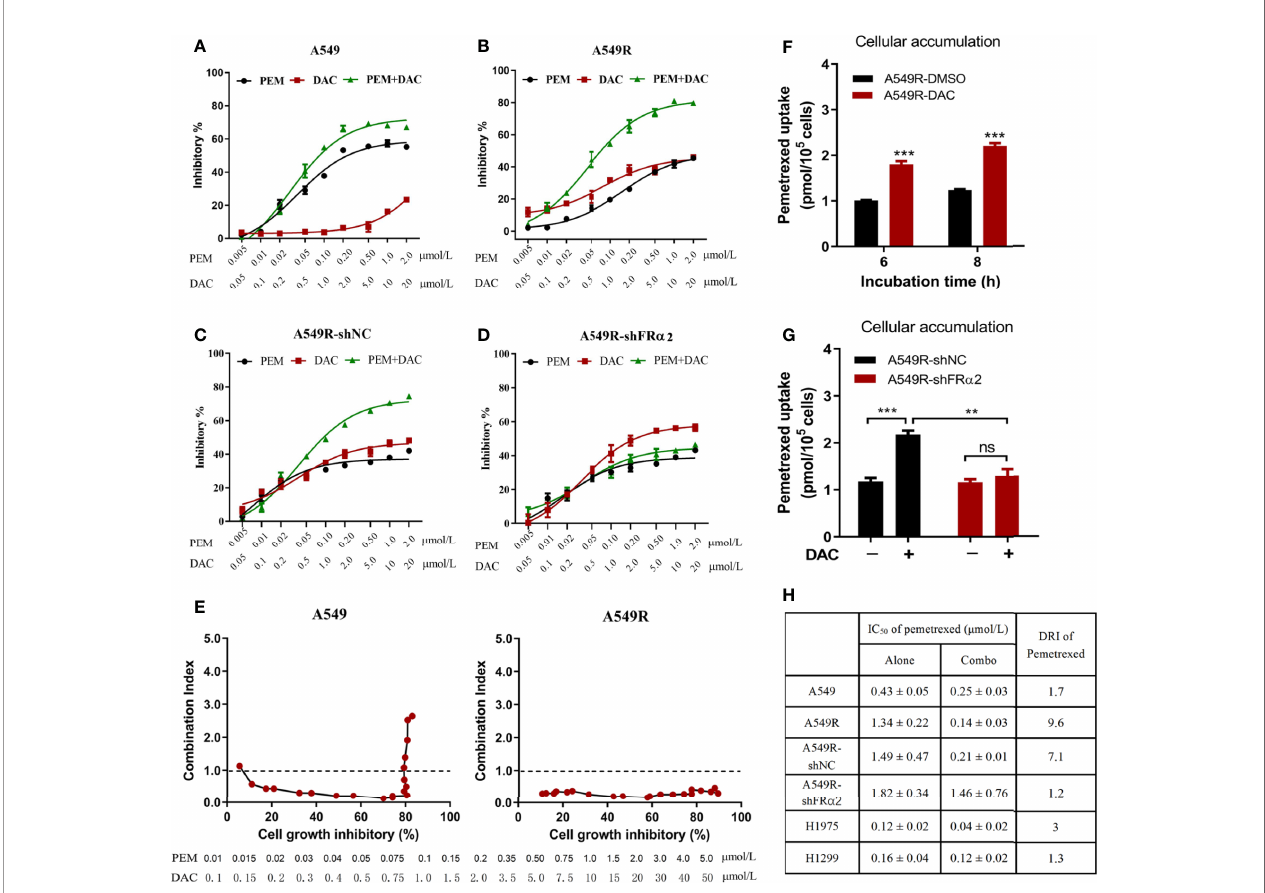
FIGURE 5 | Decitabine enhanced the cytotoxicity of pemetrexed in vitro . (A – D) A549, A549R, A549R-shNC and A549R-shFR a cells were treated with pemetrexed (PEM) and decitabine (DAC) alone or in combination, at the indicated concentrations for 96 h. The results are expressed as the percentage of surviving drug-treated cells relative to DMSO-treated control cells. (E) Combination index-fraction affected plots of pemetrexed and decitabine combinations in A549 and A549R cells. The concentration ranges of pemetrexed and decitabine are 0.01-5 and 0.1-50 m mol/L. A cytotoxicity index (CI) < 1, CI = 1, and CI > 1 indicates synergism, an additive effect, and antagonism, respectively. (F) Effects of decitabine on pemetrexed cellular accumulation. DMSO-treated and decitabine-treated (0.5 m M, 96h) A549R cells were incubated with 50 m M pemetrexed for 6 or 8 h. (G) Effects of FR a knockdown on pemetrexed cellular accumulation. DMSO-treated and decitabine-treated (0.5 m M, 96h) cells were incubated with 50 m M pemetrexed for 6 h. (H) IC 50 values and dose reduction index (DRI) of pemetrexed in cells receiving pemetrexed alone or combination treatment. DRI is the ratio of IC 50 (alone) to IC 50 (combo). (A – D, H) , data are presented as the means ± SE, n =5. E and F, data are presented as the means ± SE, n =3. Differences between cells are denoted as **p < 0.01 and ***p < 0.001. ns, not signi fi